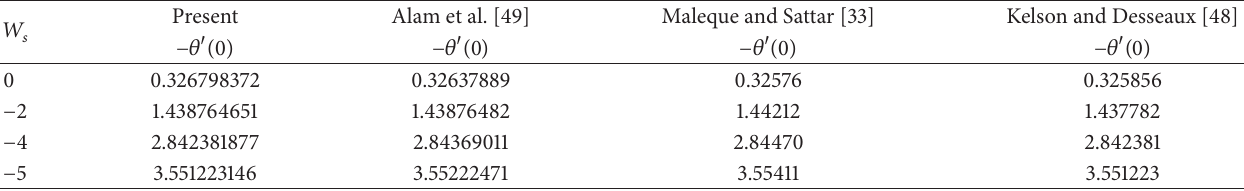
Table 3: Comparison between the results of present study with the results reported by Kelson and Desseaux [48], Maleque and Sattar [33], and Alam et al. [49] for rate of heat transfer −𝜃 󸀠 (0) for Pr = 0.71, 𝑀 = 0 , 𝜀 = 0 , Kn = 0, and 𝑁 = 0